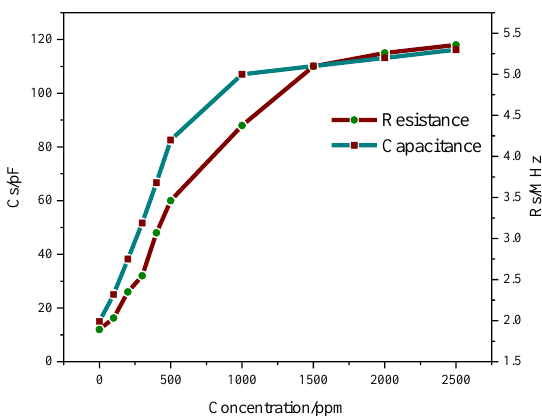
Figure 5. Capacitance and resistance experiments at different NH 3 concentrations.